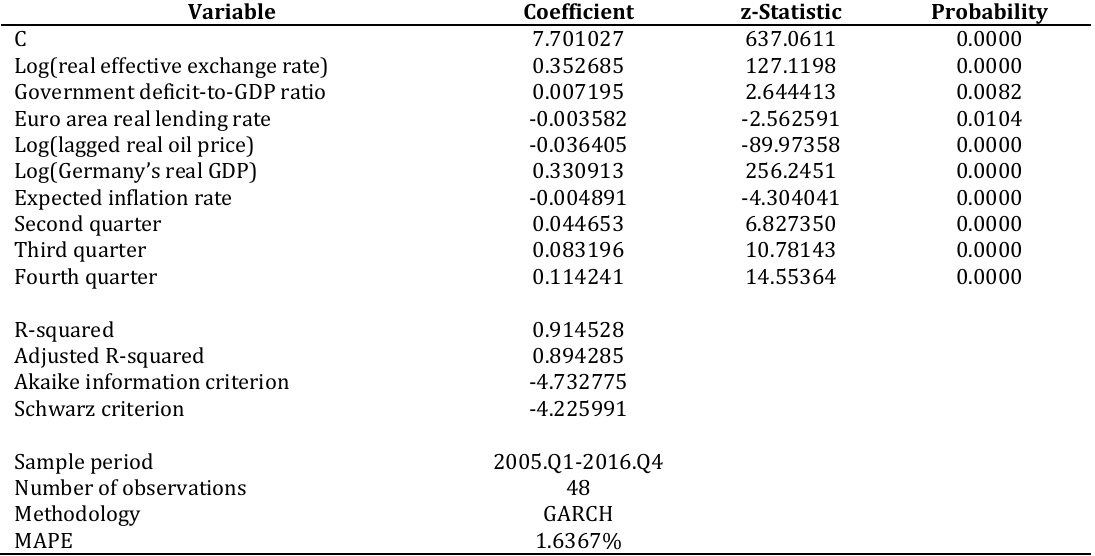
Table 1: Estimated Regression of Log (Real GDP) in